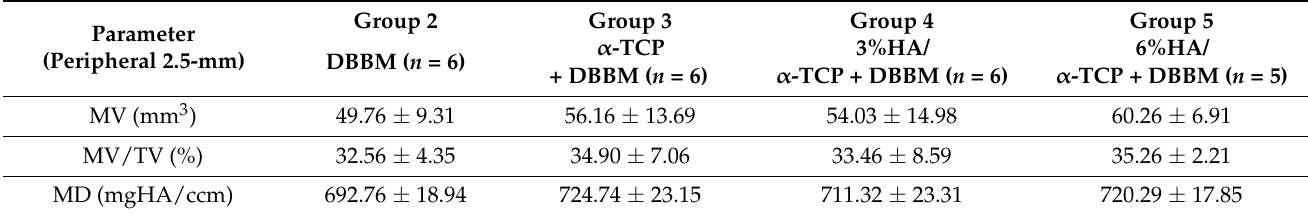
Table 4. Quantified micro-CT values in a peripheral 2.5-mm defect VOI